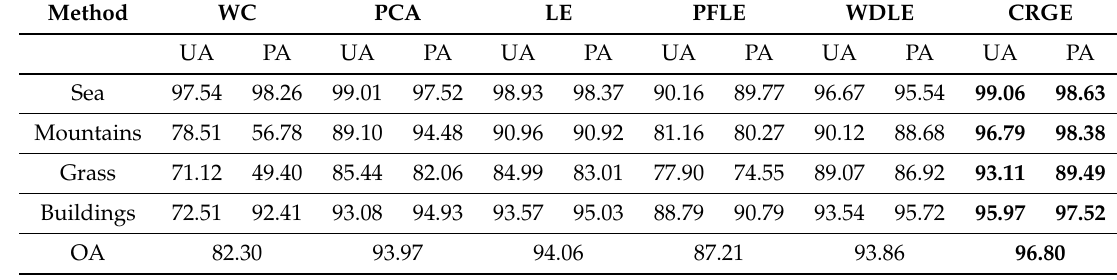
Table 4. Classification accuracies of six methods on the San Francisco Bay data set.